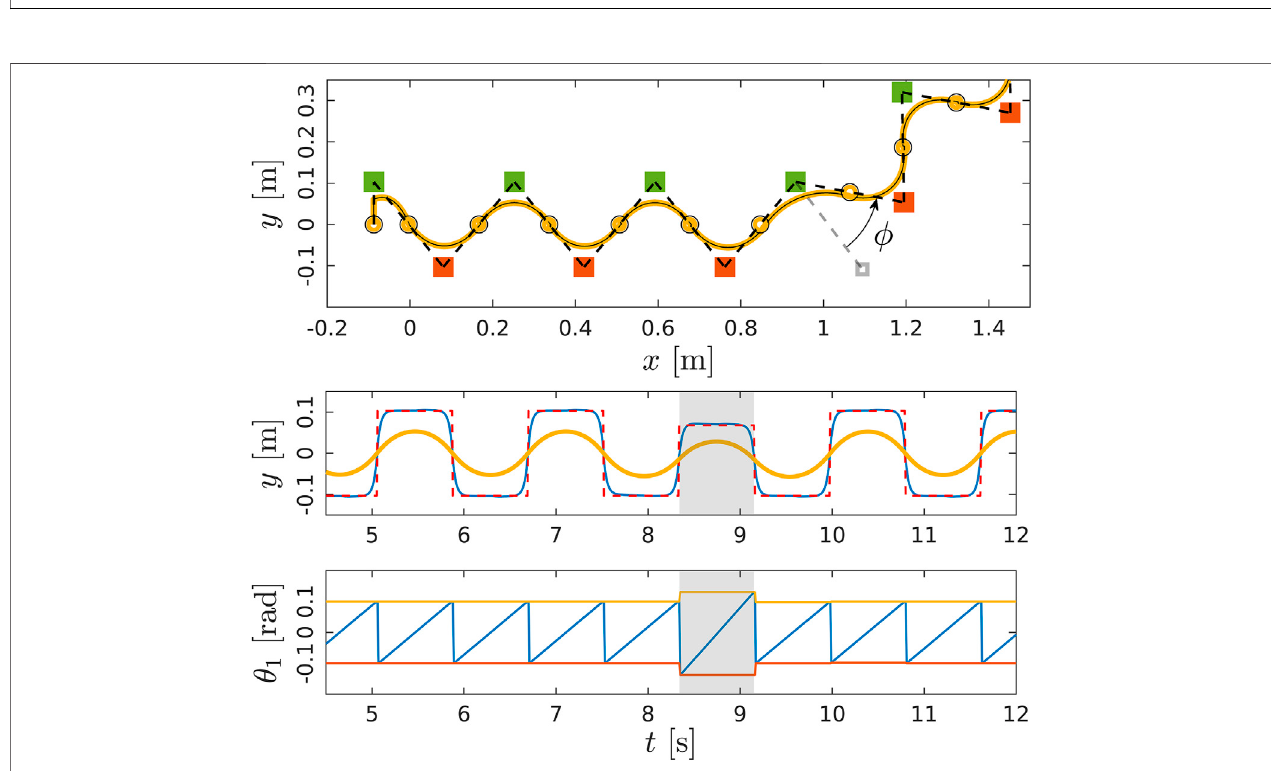
FIGURE 9 | The WPG steers the robot of an angle ϕ . Top: walking pattern of the robot, including the pose of the left (in green) and right (in red) sole and the CoM trajectory (in yellow). Middle: ZMP reference for the preview control. Bottom: the evolution of the tilt angle θ 1 . The grey area highlights the steering step.